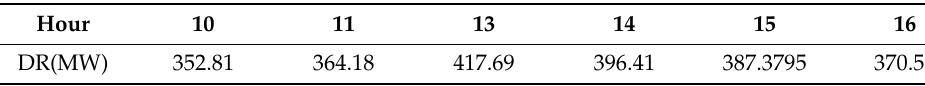
Table 2. Demand provided of user aggregators.